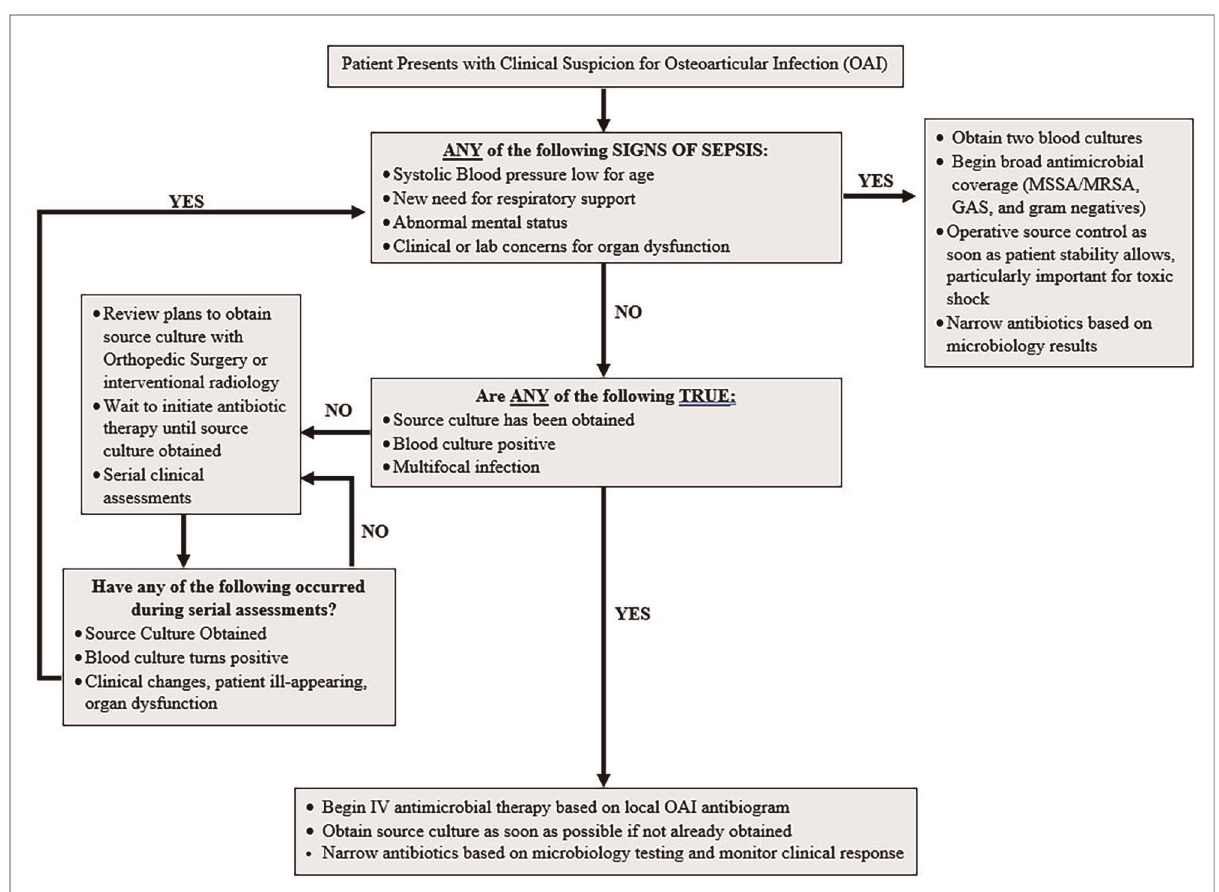
FIGURE 1 Suggested clinical pathway to follow to help determine need for immediate antimicrobial therapy and strategy to systematically re-evaluate all patients admitted with osteoarticular infections off antimicrobial therapy while expediting surgical